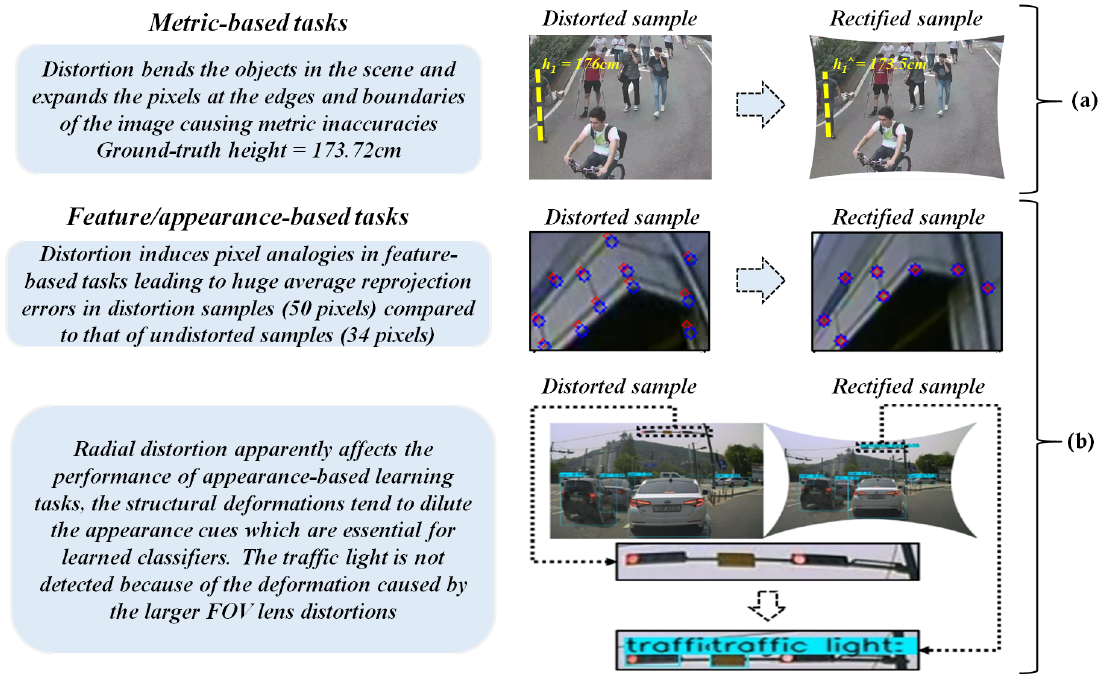
Figure 1. Effects of larger FOV distortions on high-end vision-based tasks. ( a ) Metric-based tasks and ( b ) feature/appearance-based